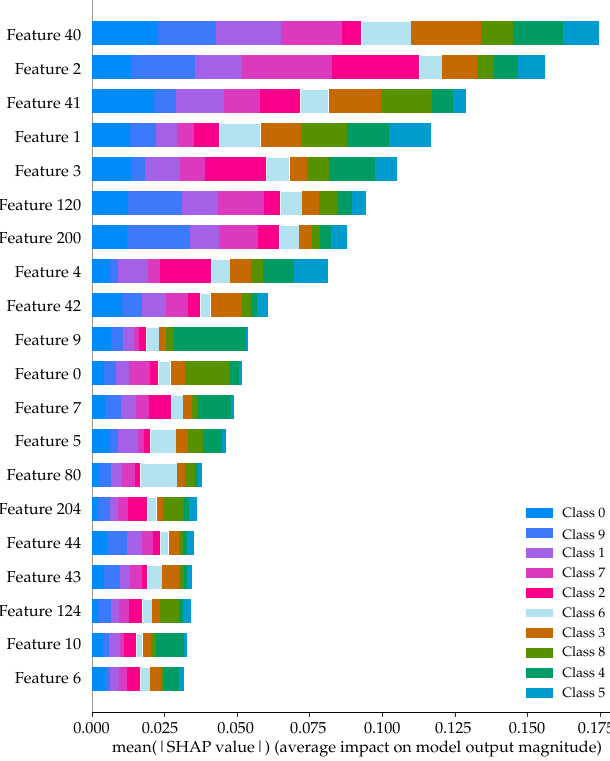
Figure 10. SHAP summary